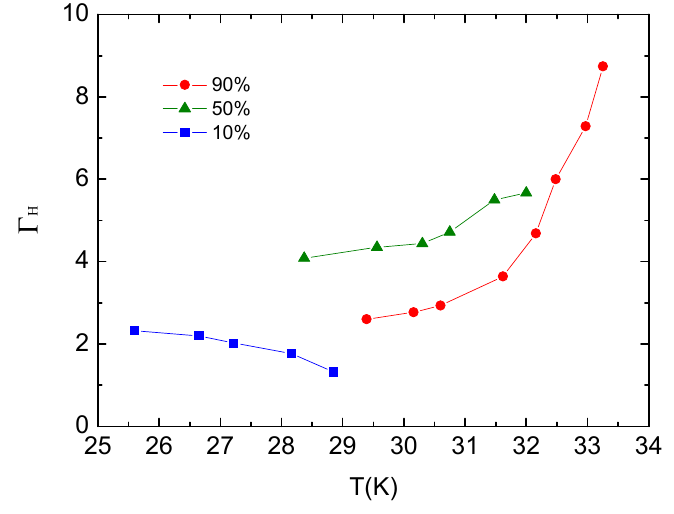
Figure 8. The temperature dependence of the H c2 anisotropy parameter Γ H = H